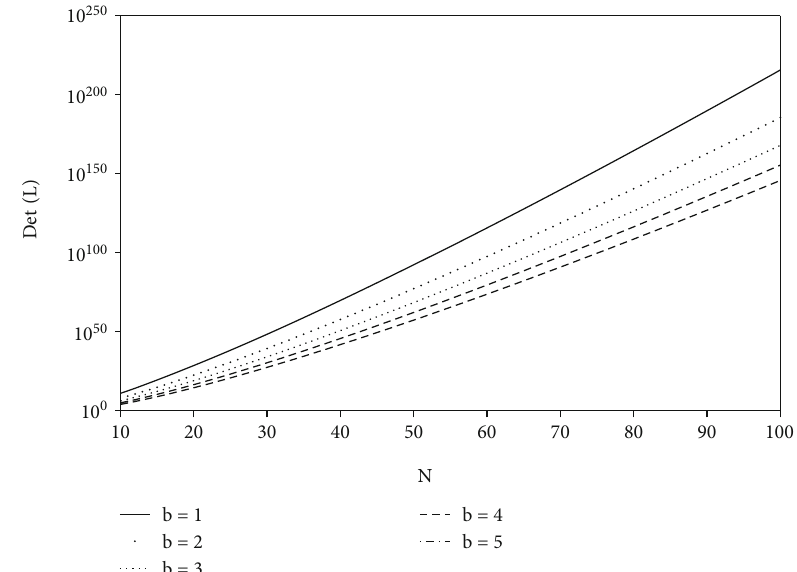
Figure 1: The determinants (det) of the matrices L